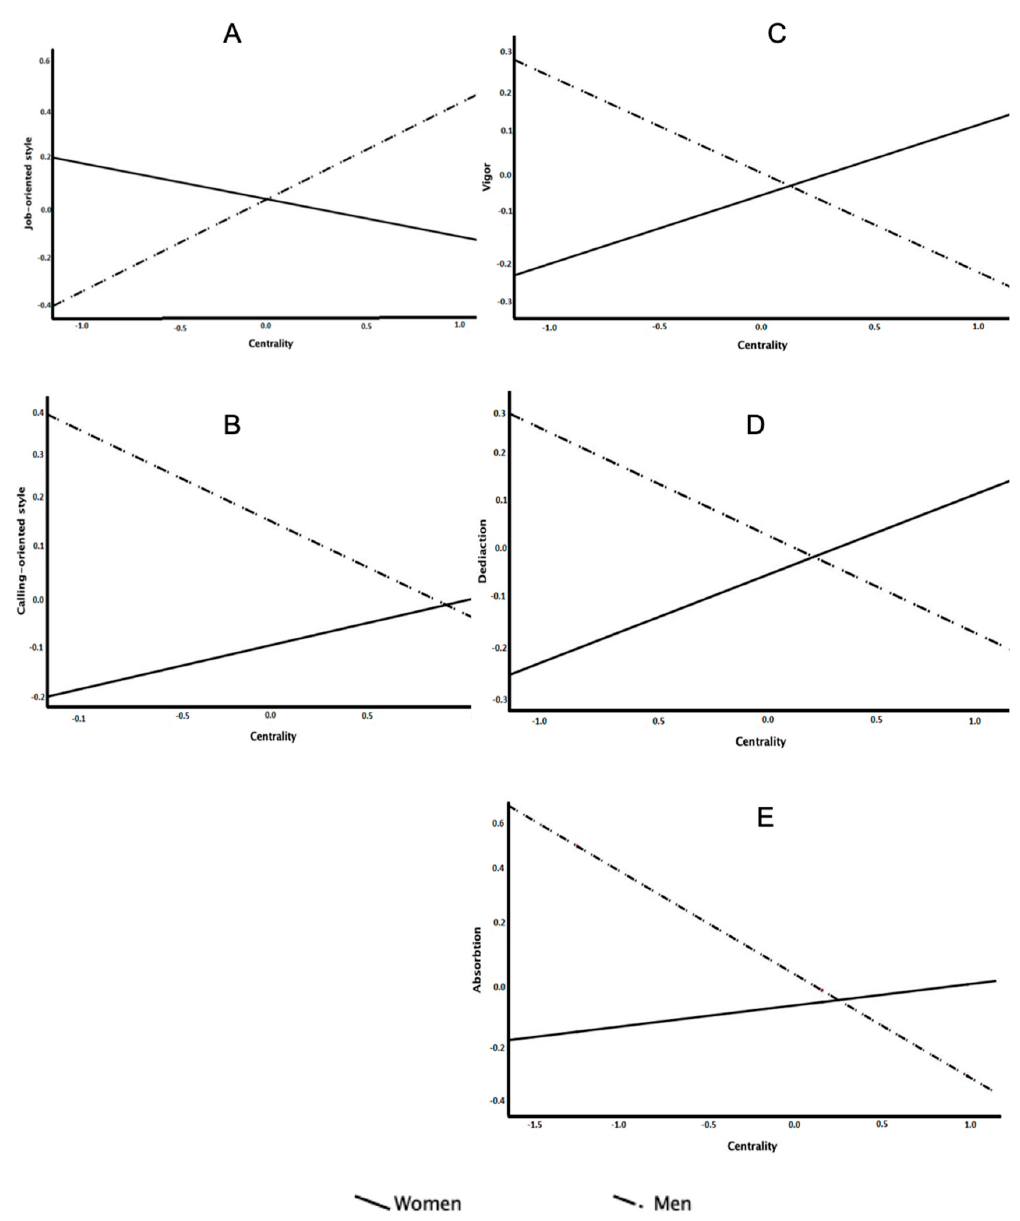
Figure 1. A visual representation of the moderation of the effect of the centrality of religiosity on work orientation styles: ( A ) job-orientated style and ( B ) calling-oriented style among women and men and on the work engagement dimensions: ( C ) vigor, ( D ) dedication and ( E ) absorption among women and men.